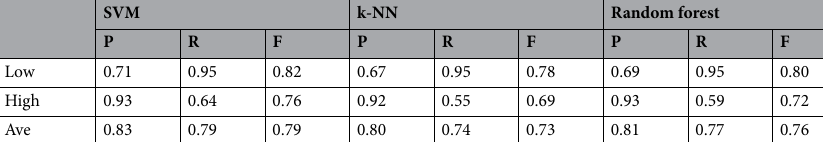
SVM k-NN Random forest